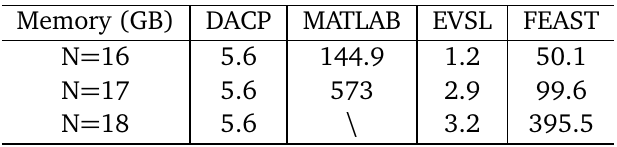
Table 2: Memory consumption of the four approaches for the Ising